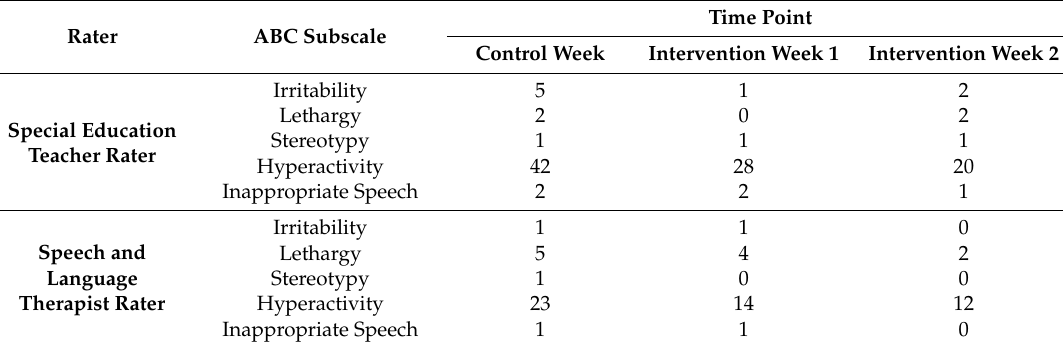
Table 4. Efficacy stage ABC subscale scores for Participant 3.